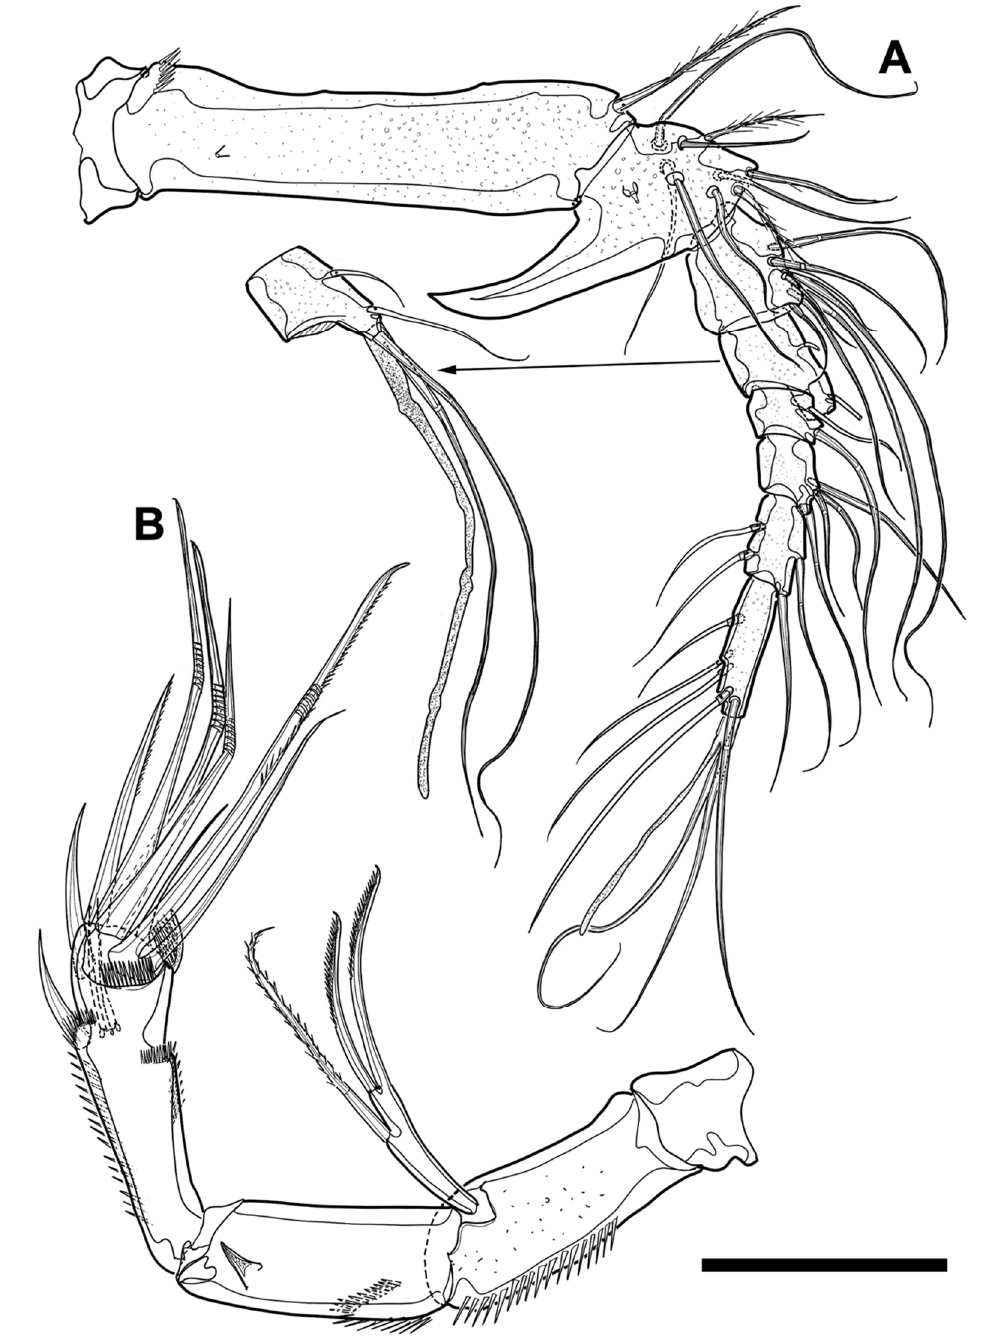
Figure 10. Line drawings of Phyllopodopsyllus saywakimi sp. nov. female (holotype): ( A ) antennule, dorsal; ( B ) antenna, anterior. Scale bar: 50